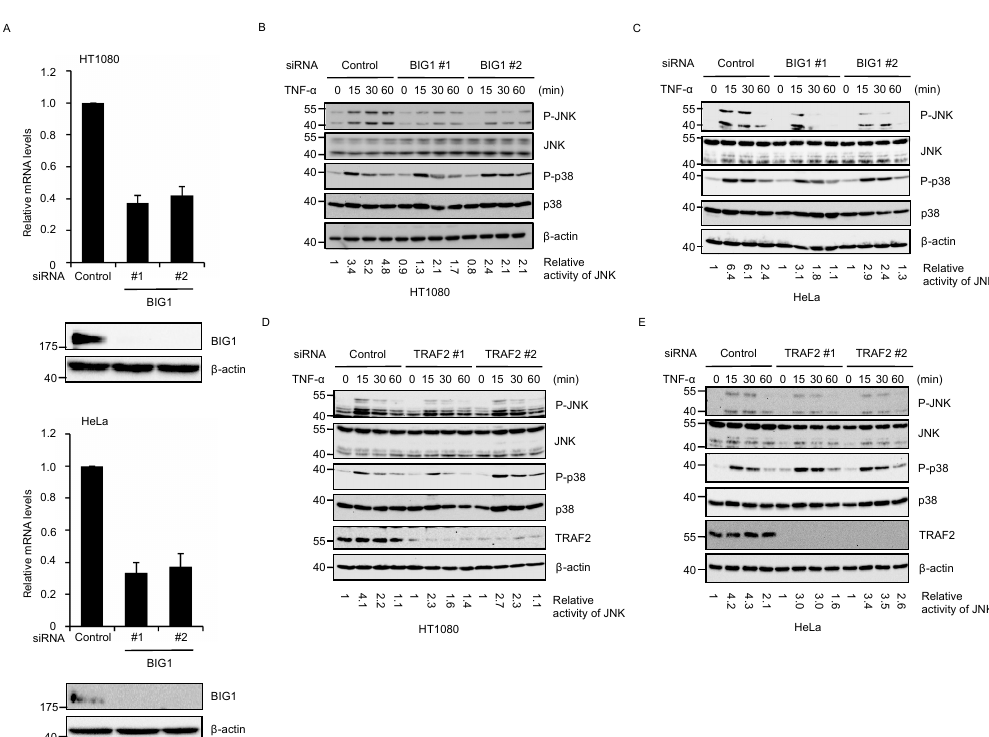
Figure 1. Brefeldin A-inhibited guanine nucleotide-exchange factor 1 (BIG1) is involved in tumor necrosis factor- α (TNF- α )-induced c-Jun N-terminal kinases (JNK) activation. ( A ) HT1080 or HeLa cells were transfected with small interfering RNA (siRNA) for negative control or BIG1 (BIG1 #1 or BIG1 #2). After 48 h, the relative mRNA levels of Big1 and protein expression of BIG1 were determined by quantitative RT-PCR and immunoblotting, respectively. Data shown are the mean ± standard error of the mean (SEM) ( n = 3); ( B – E ) HT1080 ( B ) or HeLa cells ( C ) were transfected with siRNA for negative control or BIG1. HT1080 ( D ) or HeLa cells ( E ) were transfected with siRNA for negative control or tumor necrosis factor receptor-associated factor 2 (TRAF2). After 72 h, the cells were treated with 20 ng/mL TNF- α for the indicated periods. The cell extracts were subjected to immunoblotting with the indicated antibodies. The relative activity of JNK was quantified using ImageJ software.